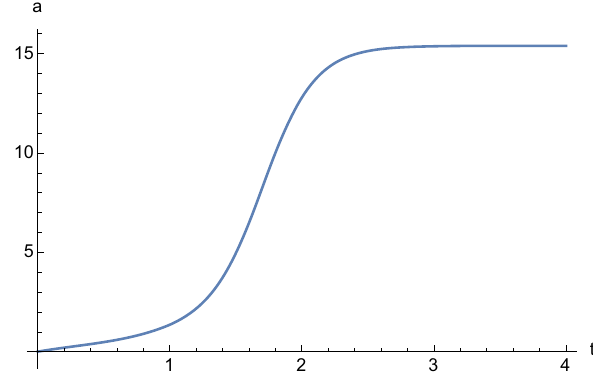
Fig. 1 Numerical solution of Eq. (34). The constants H i have all been chosen to be one and the initial condition is a ( 0 ) = 0 . 01